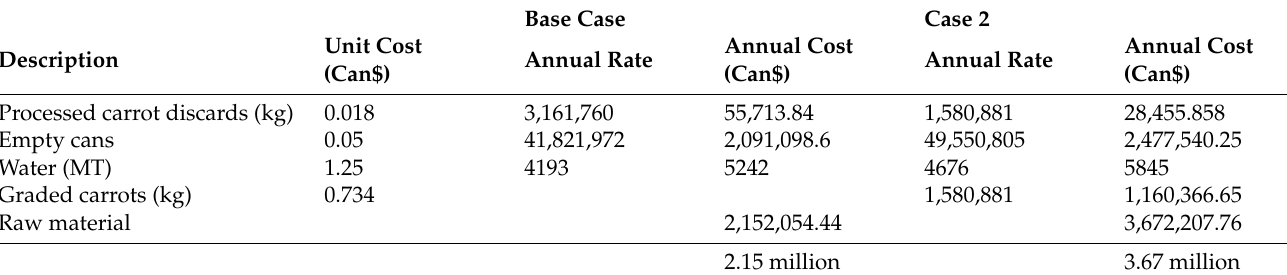
Table 4. Details of the raw material cost for the (i) base case and (ii) case